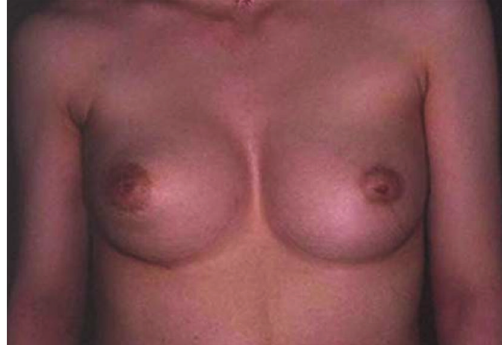
Figure 9: A saline-filled mammary prosthesis was inserted from the inframammary incision to achieve symmetry. Six months after the operation, the positions of nipples and inframammary folds are